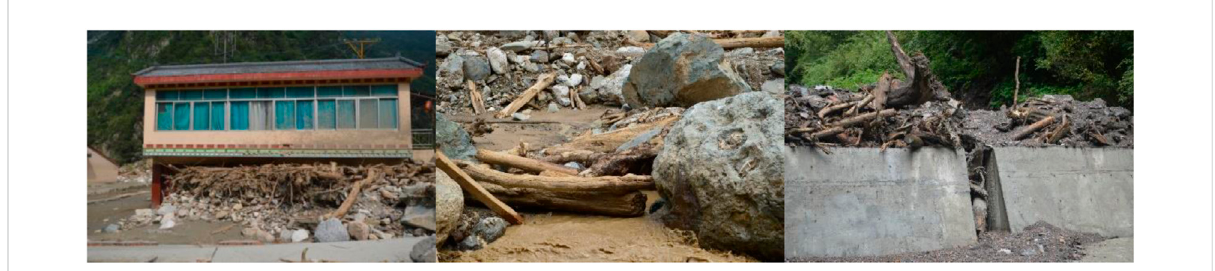
FIGURE 1 Woody debris in the debris fl ow events in the Wenchuan earthquake area.